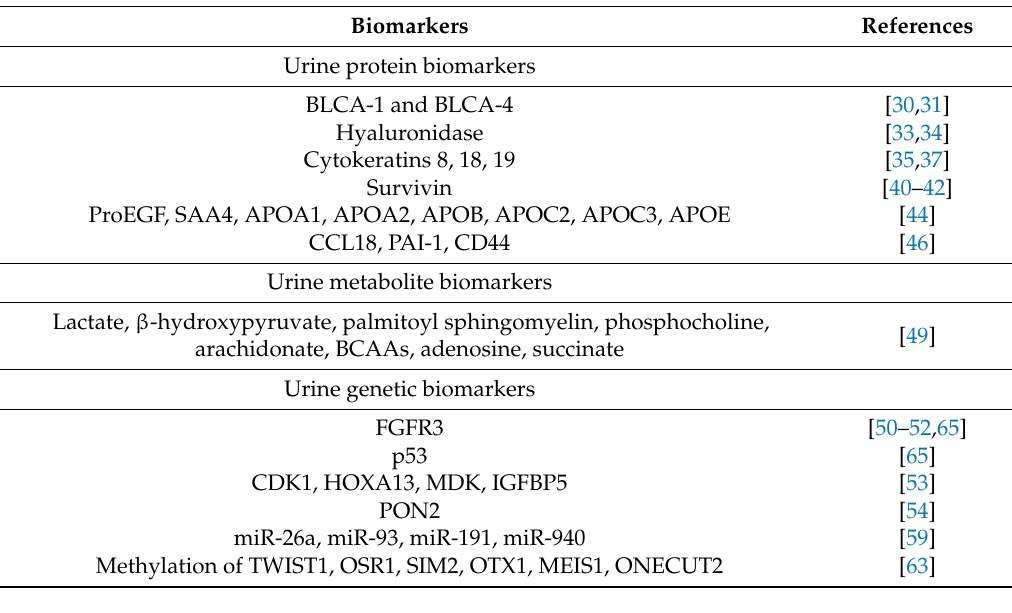
Table 2. Non-exhaustive overview of non-FDA approved urine biomarkers for bladder cancer. Twist-related protein 1 (TWIST1), Protein odd-skipped-related 1 (OSR1), Single-minded